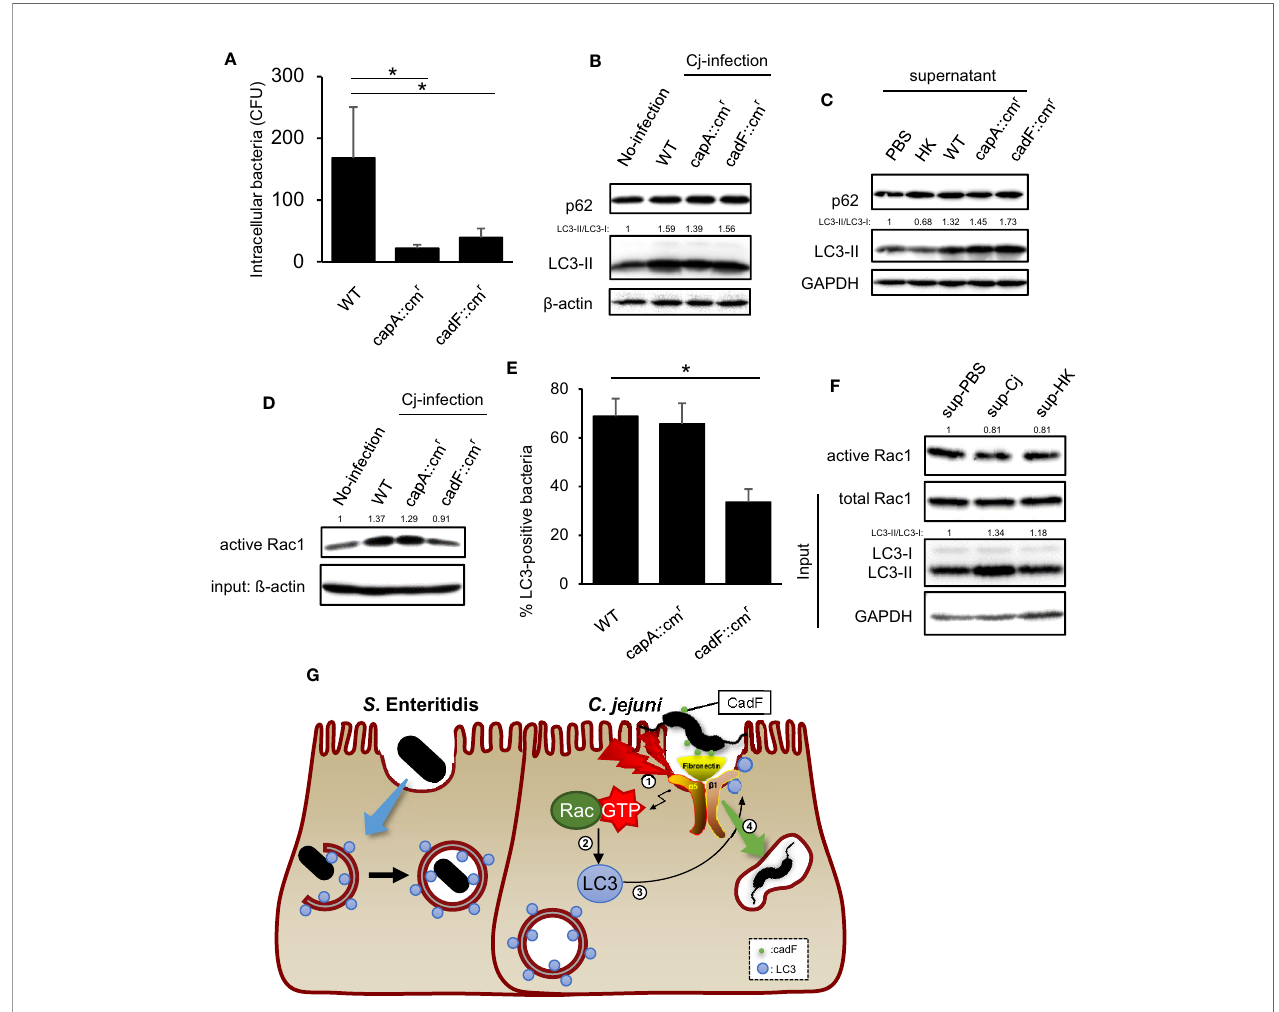
FIGURE 5 | Contribution of virulence factor in LC3-mediated C. jejuni invasion. (A) HeLa cells were infected with C. jejuni of WT, capA::cm r , and cadF::cm r . The number of intracellular C. jejuni was estimated by gentamicin protection assay at 1 h p. i. Data are expressed as means ± standard deviations (n = 4). (B) HeLa cells were infected with C. jejuni for 6 h, and detected autophagy-related proteins, p62/SQSTM and LC3 by Western blotting. (C) C. jejuni strains of WT, capA::cm r , and cadF::cm r or heat-killed bacteria were incubated in High glucose supplemented DMEM [DMEM(+)] for 24 h, and then bacterial cells were removed and the supernatant was collected. HeLa cells were cultured in bacterial removed supernatant for 6 h, and detected p62/SQSTM and LC3 by Western blotting. (D) Intracellular active Rac1 level at 6 h p. i. was measured by Western blotting. (E) Localization of LC3 and C. jejuni was observed by confocal microscope at 20 min p.i. , and the rate of LC3- positive bacteria was quanti fi ed in C. jejuni of WT, capA::cm r, and cadF::cm r infected cells. WT: n = 64, capA::cm r : n = 83, cadFcm r : n = 84 of bacterial cells which pooled from 3 independent experiments. (F) C. jejuni and heat-killed bacteria was incubated in DMEM(+) for 24 h, and the supernatant was collected. HeLa cells were cultured in aforementioned supernatant for 6 h, and intracellular active Rac1 level was measured by Western blotting. (G) Proposed model in this study for C. jejuni infection signaling which mediated by Rac1 activated by CadF, and invasion route via LC3. All data are expressed as means ± standard deviations from 3 independent experiments. Differences were evaluated with Two-tailed Student ’ s t-test. * p <